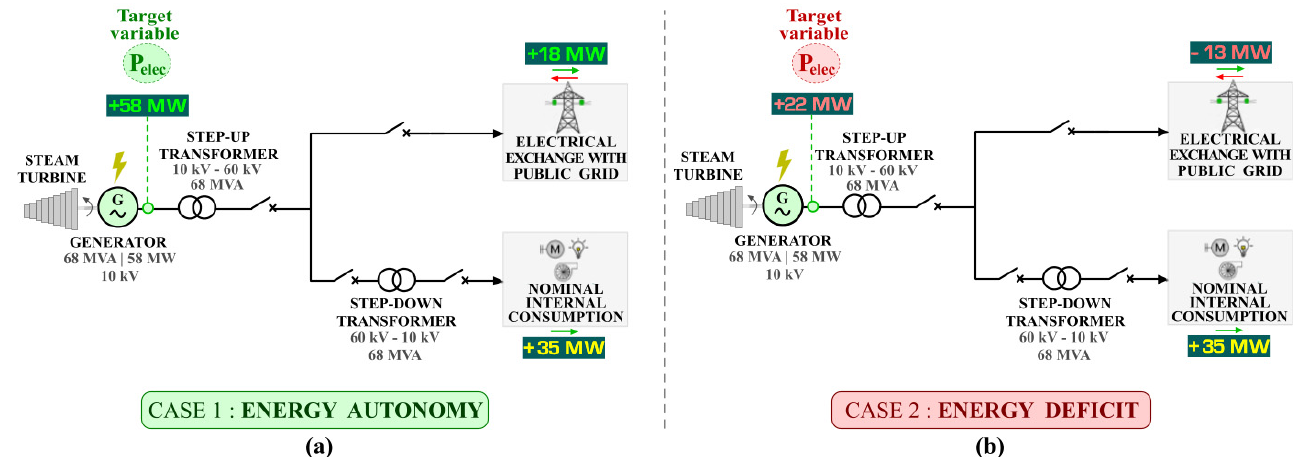
Figure 10. Electrical production of a factory self–producing electricity: ( a ) case of normal production and consumption of electricity, leading to the export of 18 MW, ( b ) case of undesirable decreasing of produced electrical power, leading to the import of 13 MW from the public grid.